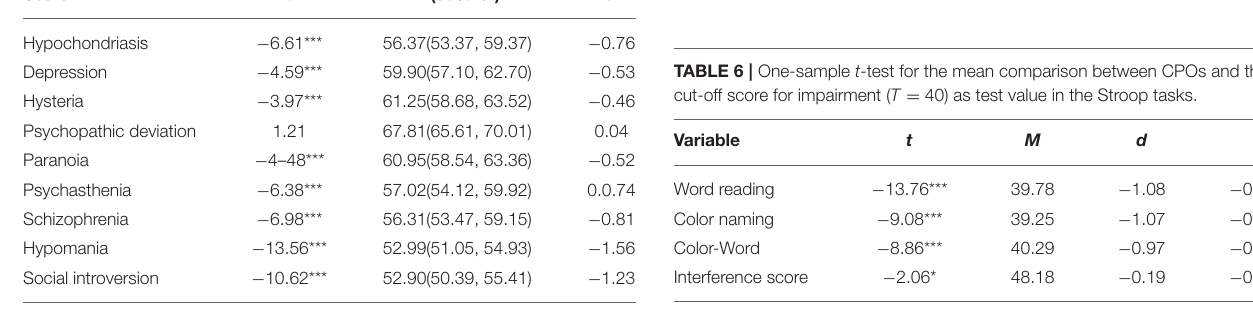
TABLE 4 | One-sample t -test for the mean comparison of CPOs with the cut-off score for caseness as test value ( T = 66.45) in the basic clinical scales. Scale